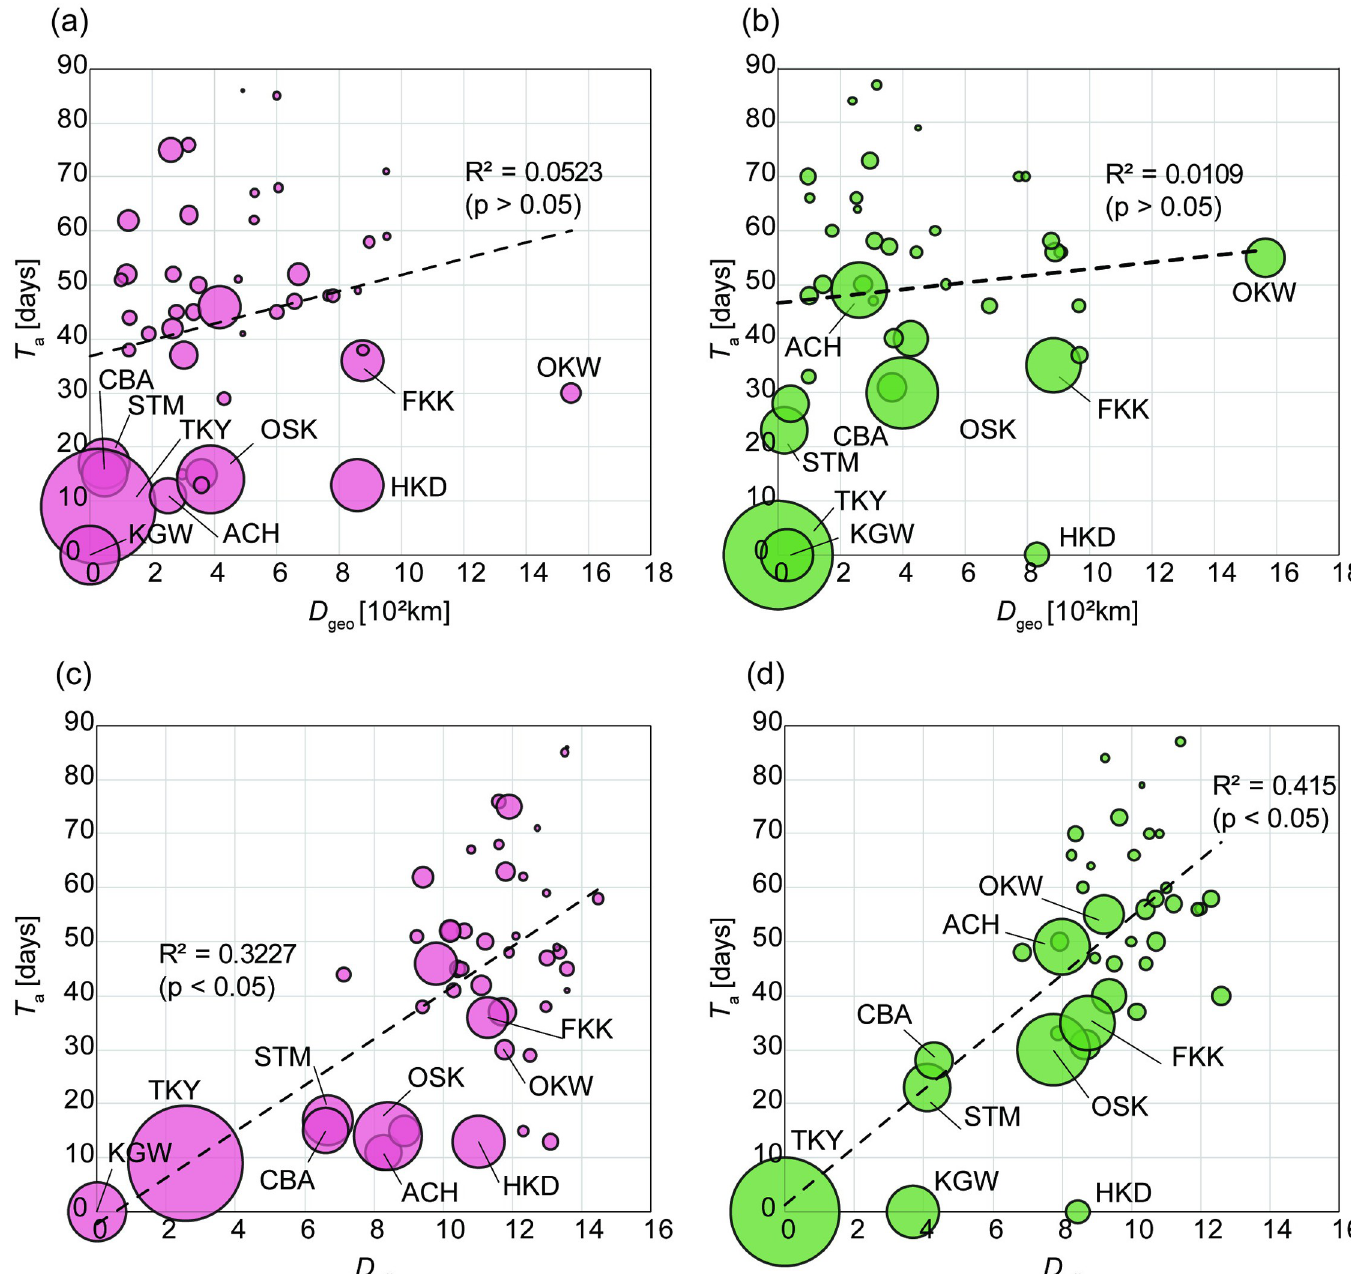
Fig 3. Linear relationship between time of arrival T a and effective distance D eff . (a and b) Linear relationship between time of arrival T a and geographical distance D geo at 1 st epidemic wave from Kanagawa (a) and at 2 nd epidemic wave from Tokyo (b). (c and d) Linear relationship between time of arrival T a and effective distance D eff at 1 st epidemic wave from Kanagawa (c) and at 2 nd epidemic wave from Tokyo (d). HKD: Hokkaido, CBA: Chiba, TKY: Tokyo, KGW: Kanagawa, ACH: Aichi, OSK: Osaka, FKK: Fukuoka, OKW: Okinawa, STM: Saitama. The size of the bubble represents the sum of the number of cases in each prefecture.